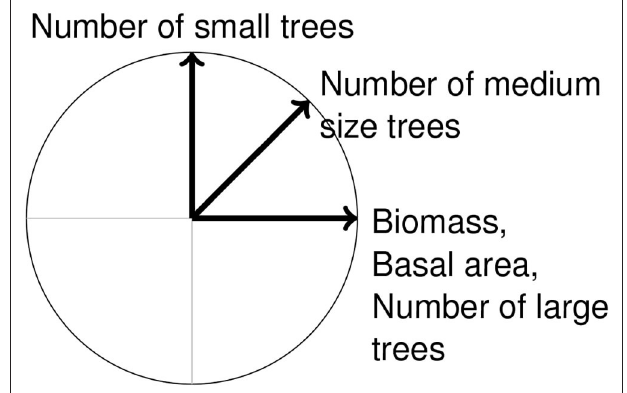
FIGURE 1 | Schematic view of the expected correlation circle between biomass, basal area, and the number of small, medium size, and large trees when ordinating tropical rain forest